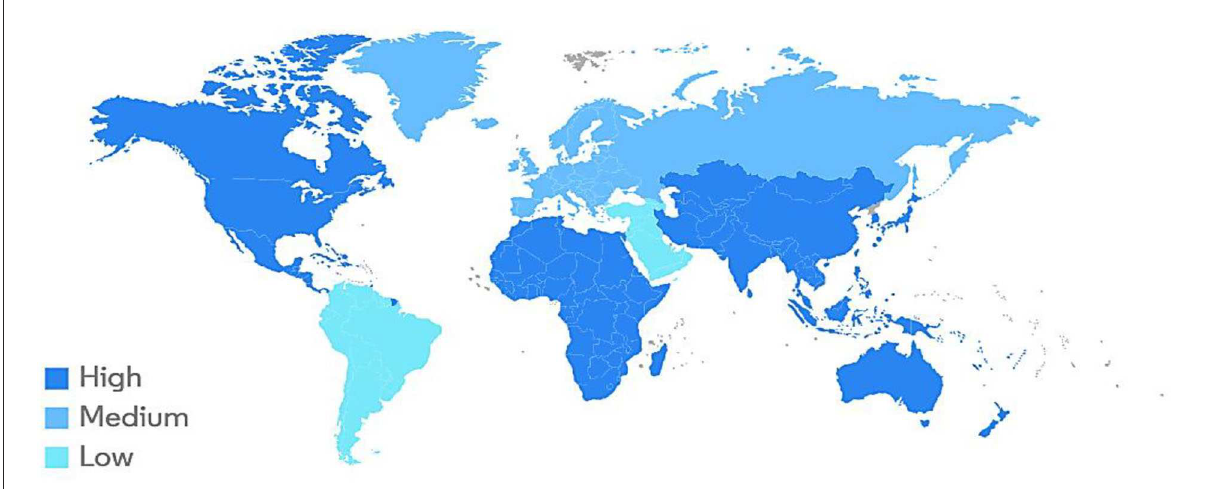
FIGURE1 World’s sesame market size (Mondor Intelligence,